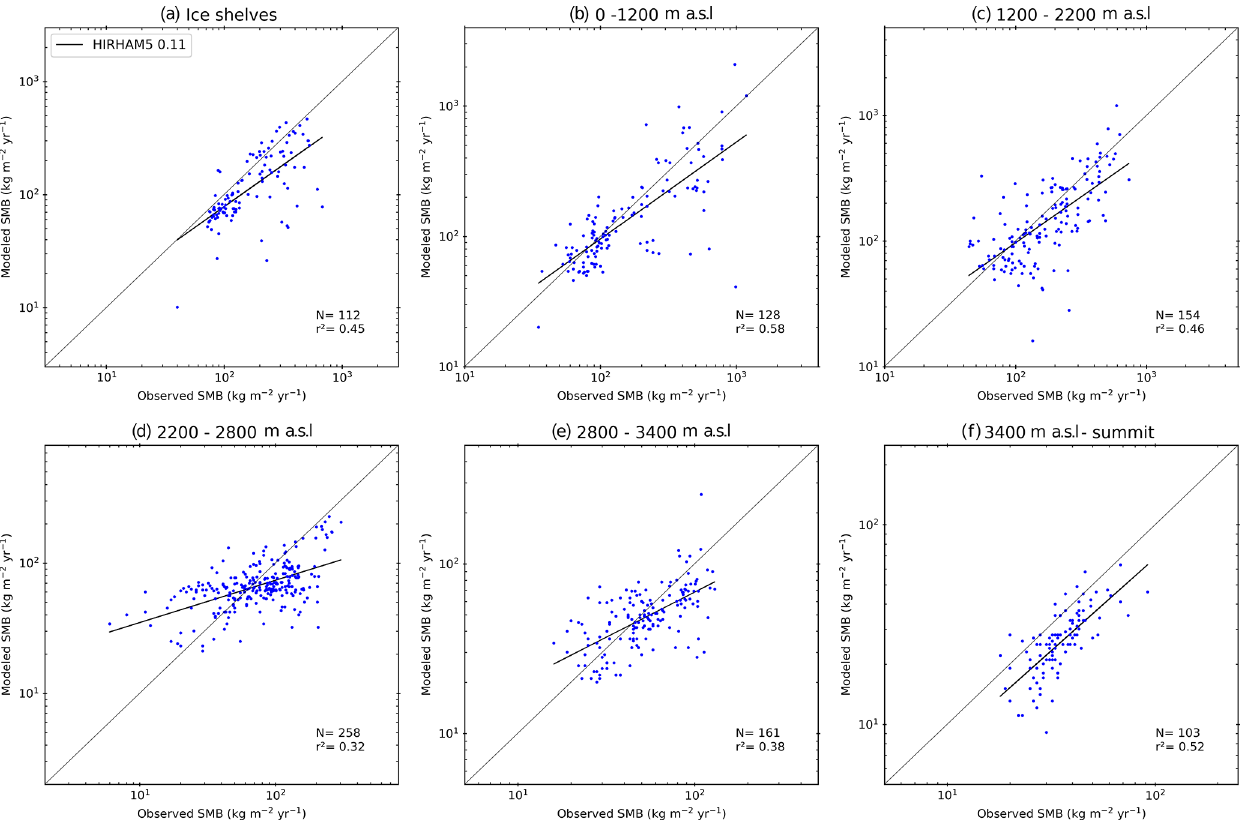
Figure A4. Comparison between HIRHAM5 0.11 ◦ and observed SMB (units: kgm − 2 yr − 1 ) over the ice shelves (a) and by elevation classes (b–f) . Due to the use of logarithmic axes, only positive values for the observed and modelled SMB from all the RCMs in this study are used (number for each bin N ). Finally, the regression coefficient of each regression line is also shown ( r 2